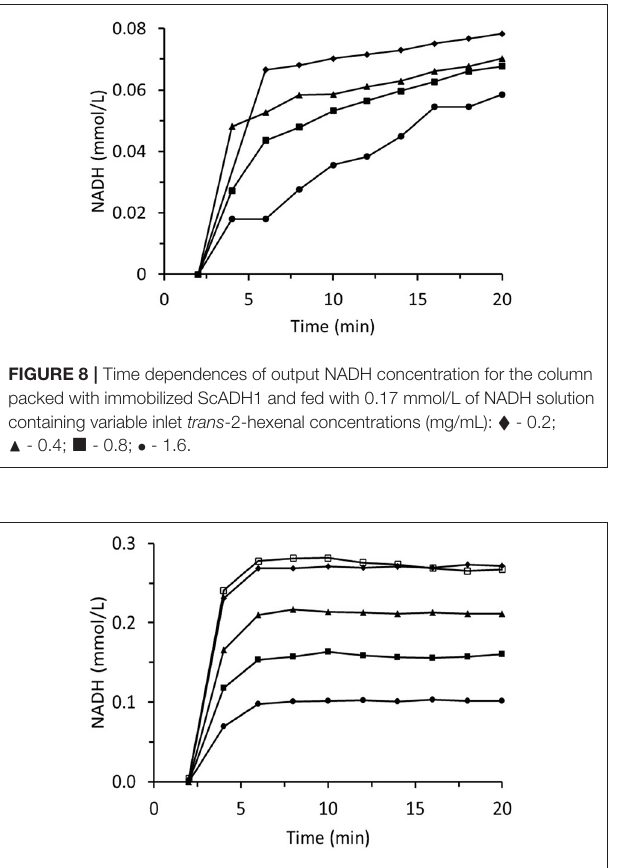
FIGURE 9 | Time dependences of output NADH concentration for the column packed with immobilized ScADH1 and fed with 0.17 mmol/L of NADH solution containing variable inlet trans -2-hexenol concentrations (mg/mL): (cid:7) - 0.2; N - 0.4; (cid:4) - 0.8; • - 1.6; (cid:3) -